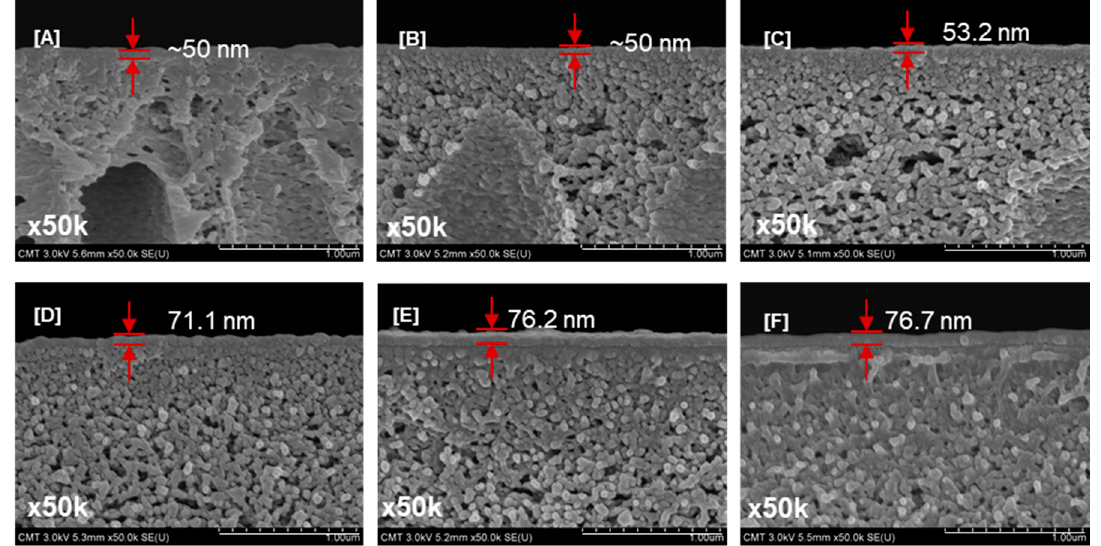
Figure 6. Cross-sectional images of thin-film composite membranes prepared using PEG of varying molecular weights: ( A ) TFC–0; ( B ) TFC–PEG200; ( C ) TFC–PEG1k; ( D ) TFC–PEG10k; ( E ) TFC–PEG20k;